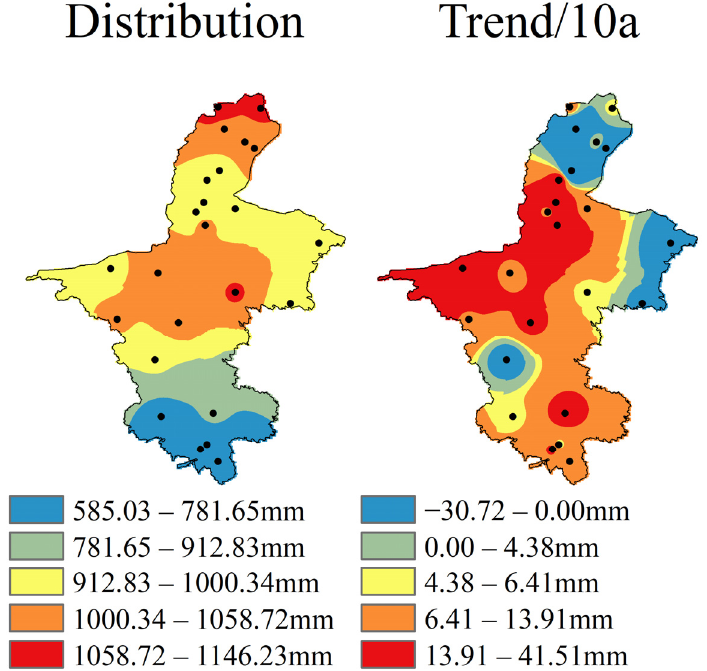
Figure 2. Spatial characteristics of potential evaporation during the growing season in Ningxia Autonomous Region.